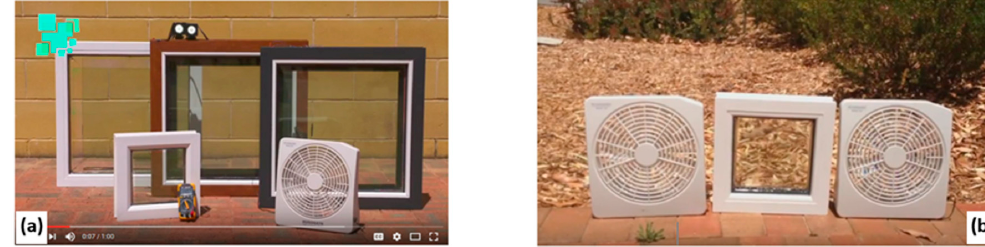
Figure 6. Examples of several earlier solar window design types ( a ) and an illustration of their application potential ( b ).